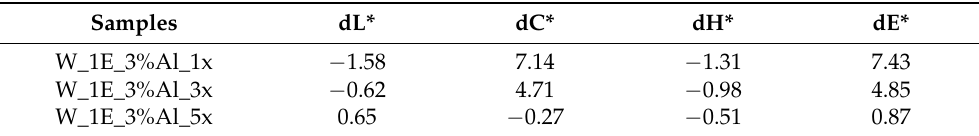
Table 16. Change in color coordinates of cotton samples dyed with SJL aqueous extract with 3% Al mordants after 1st, 3rd and 5th washing cycle (compared with W_1E_3%Al_0x).